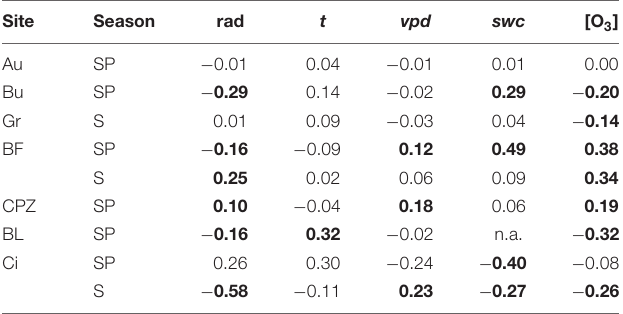
TABLE 6 | Spearman partial correlation coefficients of the negative partial derivative of dNEP(O 3 ) (FO 3sto for Au, Bu, Gr, CPZ and Ci in Summer; FO 3cum for BF, Bl and Ci in Spring) with respect to solar radiation (rad), air temperature (t), vapor pressure deficit ( vpd ), soil water content ( swc ) and O 3 concentration at canopy level([O 3